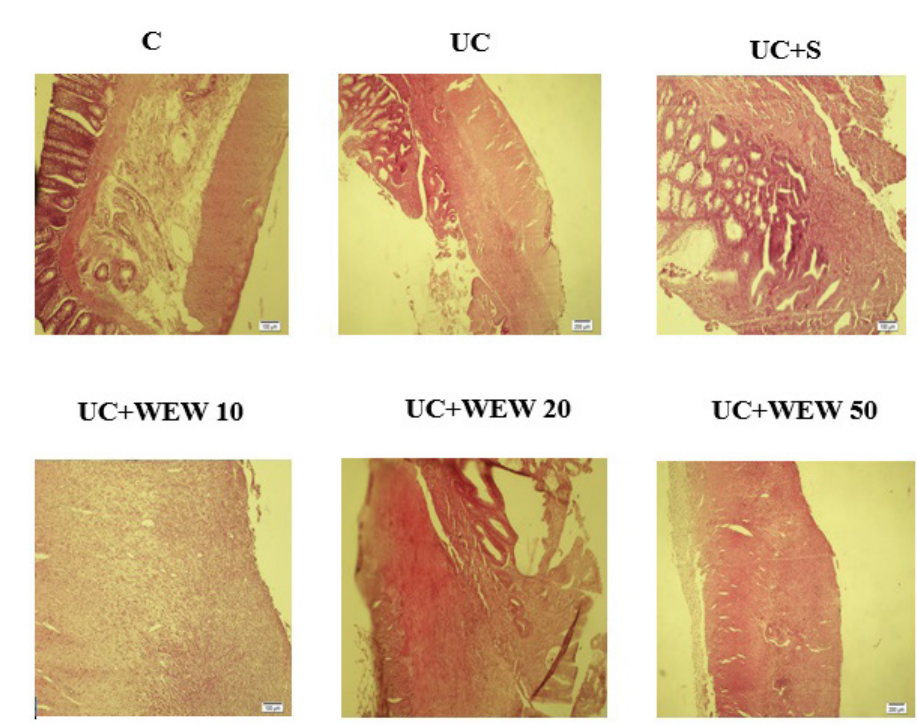
FIGURE 5 - Photographs of colon specimens under a light microscope (X40), in control (C), ulcerative colitis group (UC), ulcerative colitis rats treated with sulfasalazine (UC+S) and woody endocarpium of wulnut extract